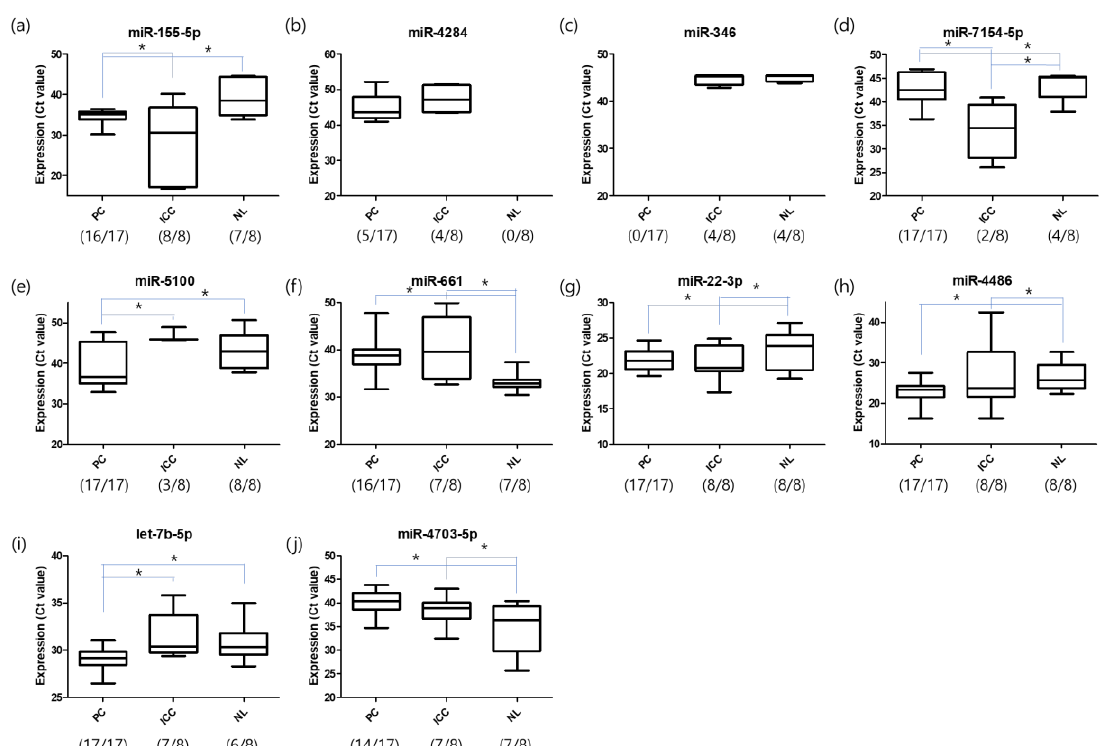
Figure 5. miRNA expression determined using quantitative reverse transcription (qRT-PCR). Differential expression levels of miRNAs selected from the chip data were further analyzed using qRT-PCR to confirm the expression levels in the serum samples of patients with PC ( n = 17), patients with ICC ( n = 8), and healthy individuals ( n = 8). The expression levels of ( a ) miR-155-5p, ( b ) miR-4284, ( c ) let-346, ( d ) miR-7154-5p, ( e ) miR-5100, ( f ) miR-661, ( g ) miR-22-3p, ( h ) miR-4486, ( i ) let-7b-5p, and ( j ) miR-4703-5p were analyzed using primers for mature miRNAs (* p -value < 0.05). The number of samples with expression is indicated as (Number Expression /Number Total ). PC, pancreatic cancer; ICC, intrahepatic cholangiocarcinoma; NL, normal or non-cancer.